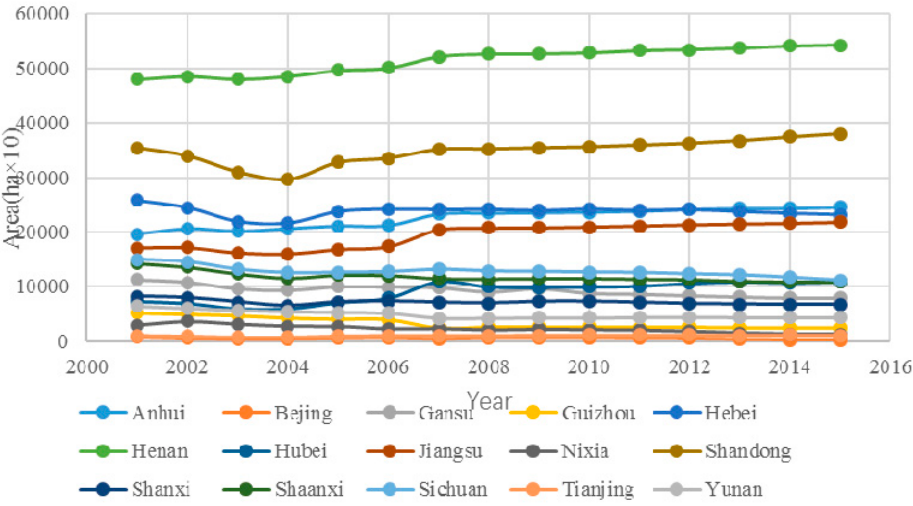
Figure A1. The area of each statistical province from 2001 to 2015.